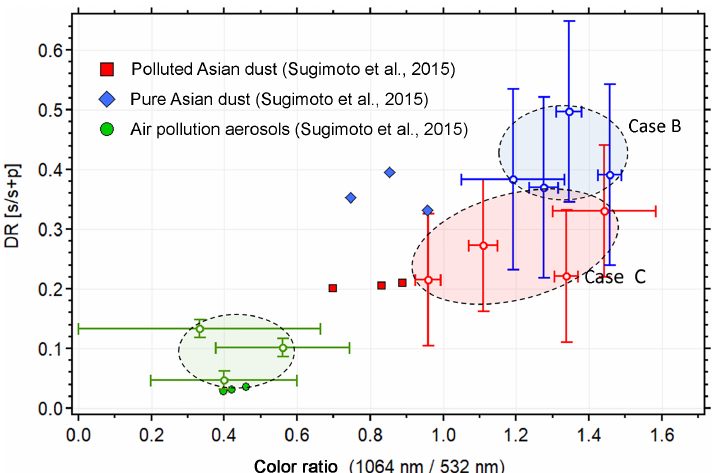
Figure 9. Scatter diagram between the backscattering color ratio (1064nm/ 532nm) and the particle depolarization ratio at 532nm for case B (dust-dominant case) and C (polluted dust case) and an anthropogenic-dominant case. The error bars indicate estimates of statistical error. The observations results in Seoul in a previous study are displayed in the plot.